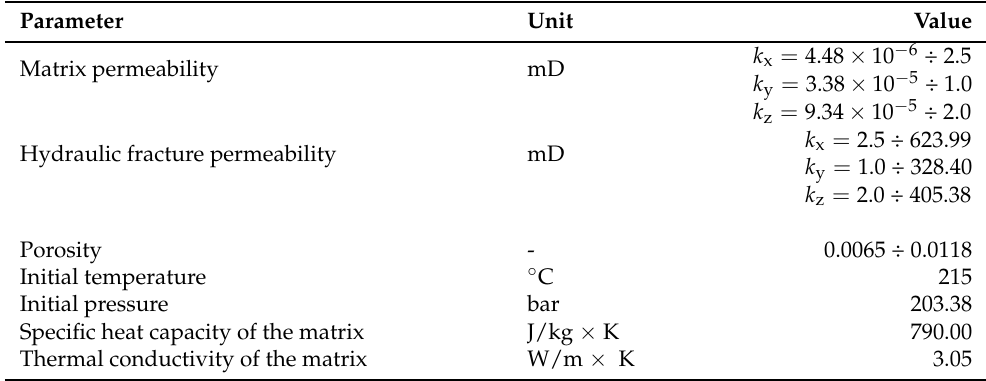
Table 3. Reservoir properties of the SRV region for the reference modelled case